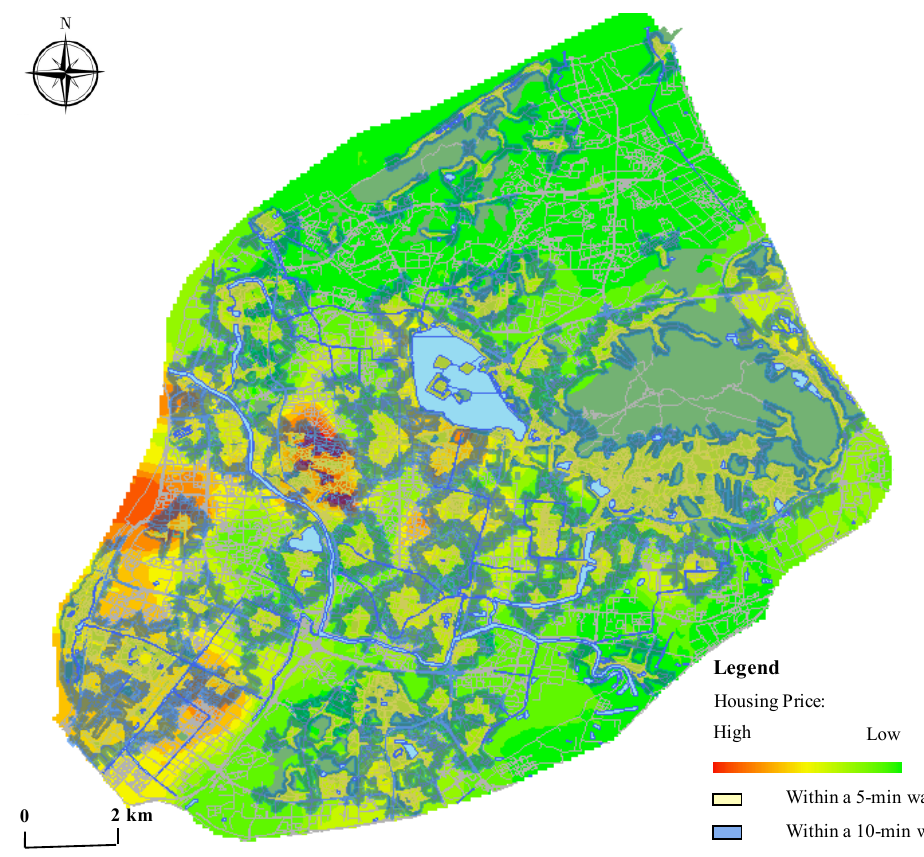
Figure 4. The distribution of park Accessibility and the housing prices in Nanjing.